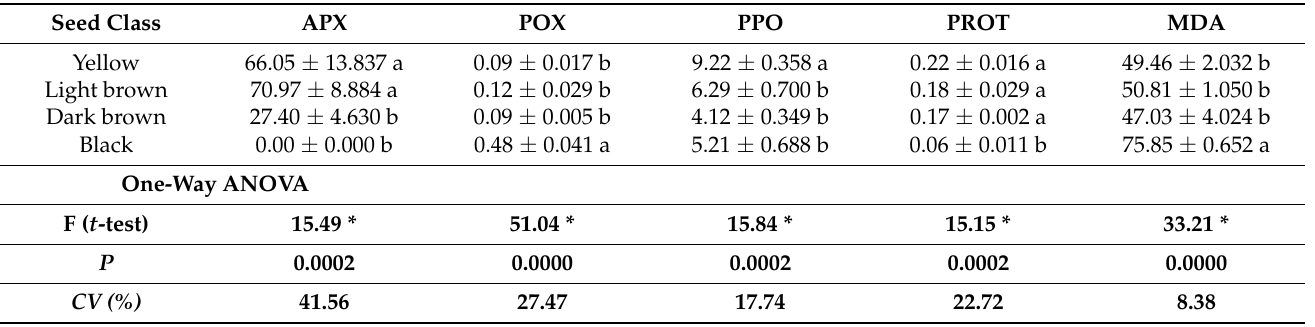
Table 5. Ascorbate peroxidase (APX) (nmol/min/mg protein), peroxidase (POX) ( µ mol/min/mg protein), polyphenol oxidase (PPO) (nmol/min/mg protein), protein (PROT) (mg/mg of fresh mass) and malondialdehyde (MDA) ( µ mol/mg of fresh mass) in different Pterodon pubescens seed